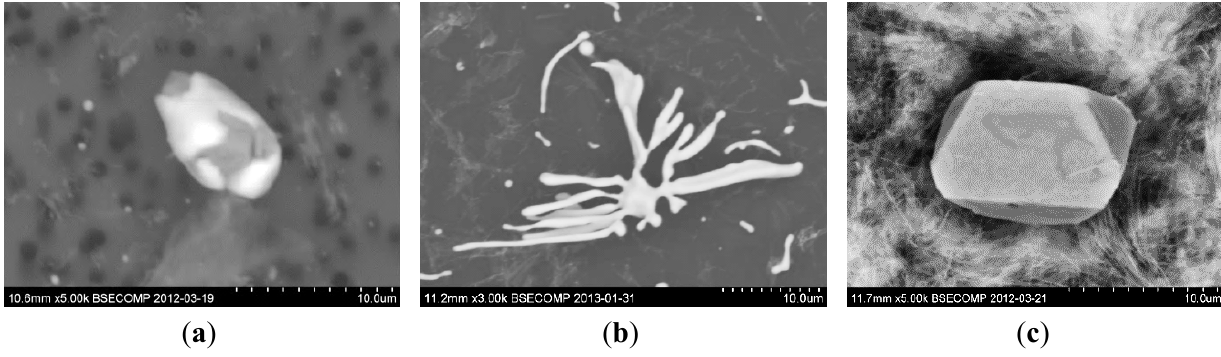
Figure 12. Schematic illustration of the relationship between activities of O, Mn and S and the morphology of oxy-sulfides and sulfides in steel [47,48].